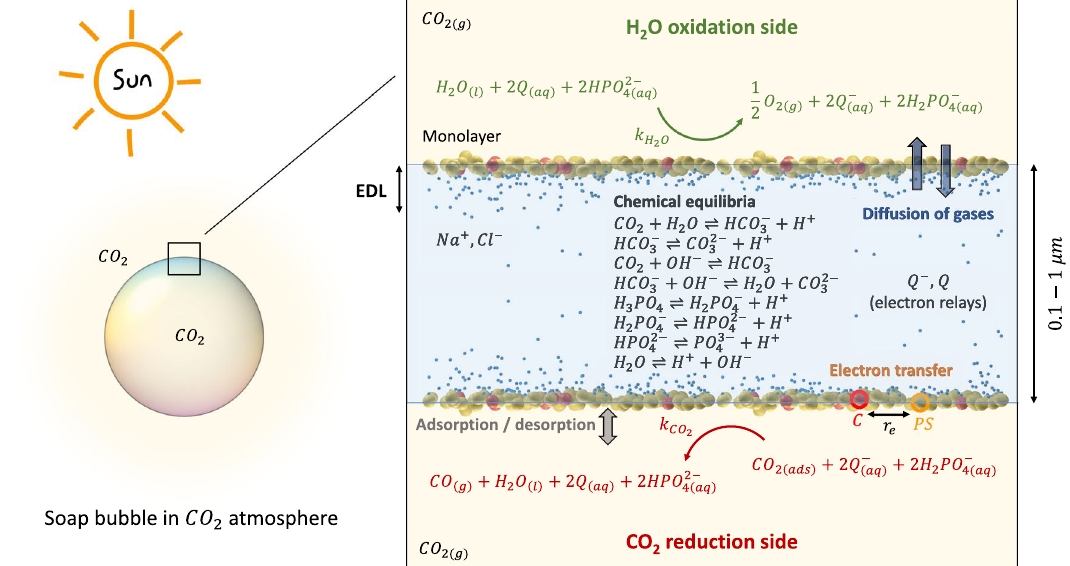
Fig. 1 Physicochemical model of a (photo)reactive soap film. Soap bubbles (and soap films) are soft liquid membranes which are considered here for temporary gas compartmentalization. Soap films consist of a thin water core (typically ranging from few dozens of nanometers up to a few microns), decorated at the two interfaces by functional surfactant molecules that can, in principle, perform CO 2 reduction and H 2 O oxidation when exposed to sunlight. These latter two half reactions are triggered by the interaction between photosensitizers (PS) and catalysts (C) and coupled by the diffusion of the electron relays (Q and Q − ) and of the phosphate buffer (which acts as a proton acceptor and donor) in the bulk. The gas solubilization, with the consequent CO 2 dissociation, occurs in the bulk where an equilibrium is established among water, gas and phosphate buffer. Electrostatic interactions are responsible for the development of an electric double layer (EDL) at the liquid side of the two surfactant monolayers, whereas Na + and Cl − guarantee the electroneutrality of the system. The produced gases tend to diffuse from one side to the other of the soap film membrane, driven by a concentration gradient resulting from the